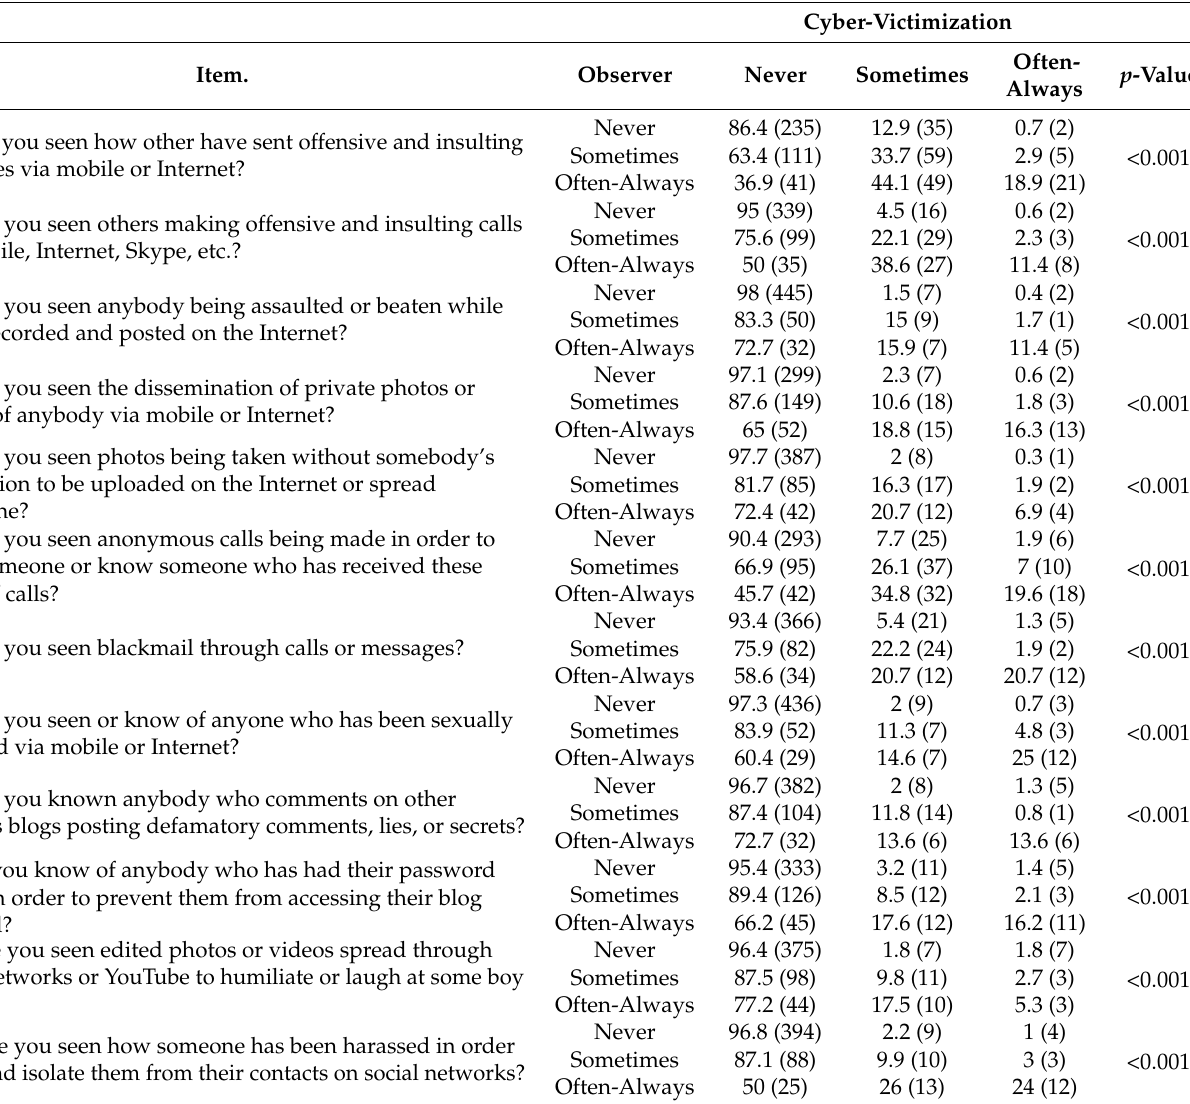
Table 3. Cyberbullying behaviours. Cyber-victimisation and observation. Chi Square Test (% row (N)). Cyber-Victimization Item. Observer Never